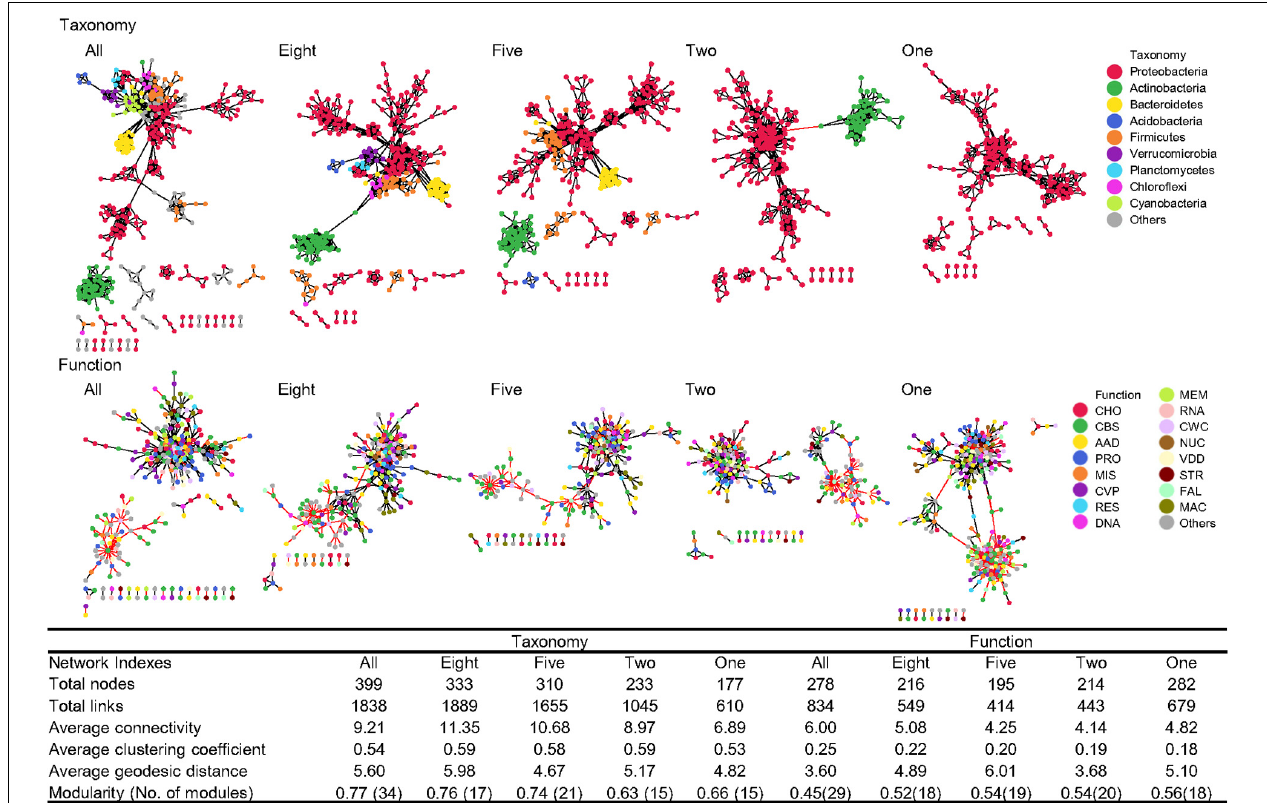
FIGURE 6 | Co-occurrence networks. Network graphs of taxonomic compositions at the genus level (Taxonomy) and functional categories at level 3 (Function) affected by sequential species loss. Node color represents classification of taxonomic compositions at phylum levels and functional categories at level 1. A black edge indicated a positive interaction between two nodes, while a red edge indicated a negative interaction. The summary of key network indexes is given in the table. AAD, amino acids and derivatives; CBS, clustering-based subsystems; CHO, carbohydrates; CVP, cofactors, vitamins, prosthetic groups, pigments; CWC, cell wall and capsule; DNA, DNA metabolism; FAL, fatty acids, lipids, and isoprenoids; MAC, metabolism of aromatic compounds; MEM, membrane transport; MIS, miscellaneous; NUC, nucleosides and nucleotides; PRO, protein metabolism; RES, respiration; RNA, RNA metabolism; STR, stress response; and VDD, virulence, disease, and